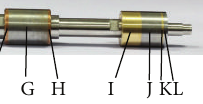
Figure 2: Rotor of the AMB